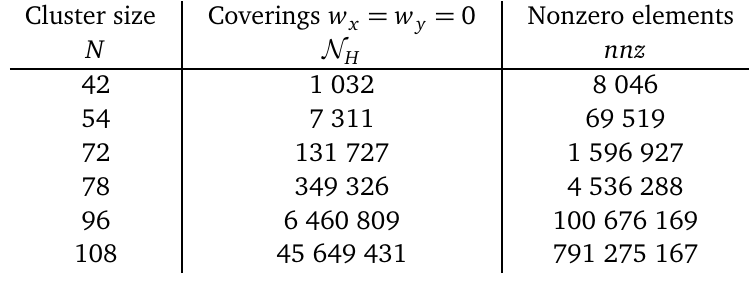
Figure 1: Dimers on the honeycomb lattice. (a) Untilted N = 72 cluster. We consider periodic boundary conditions. The lattice is split in two parts (here shown in red and blue) for the computation of the bipartite entanglement. (b) Example of dimer covering, namely the star configuration that is used as a reference for the computation of the imbalance (Sec. 3.2) and as initial state for the quenched dynamics (Sec. 3.4). The definition of the phases φ used to define the imbalance in Sec. 3.2 are shown p for each plaquette. (c) Computation of the two independent winding numbers on a single plaquette. Table 1: Matrix size N and number of nonzero elements nnz for the clusters that H have been